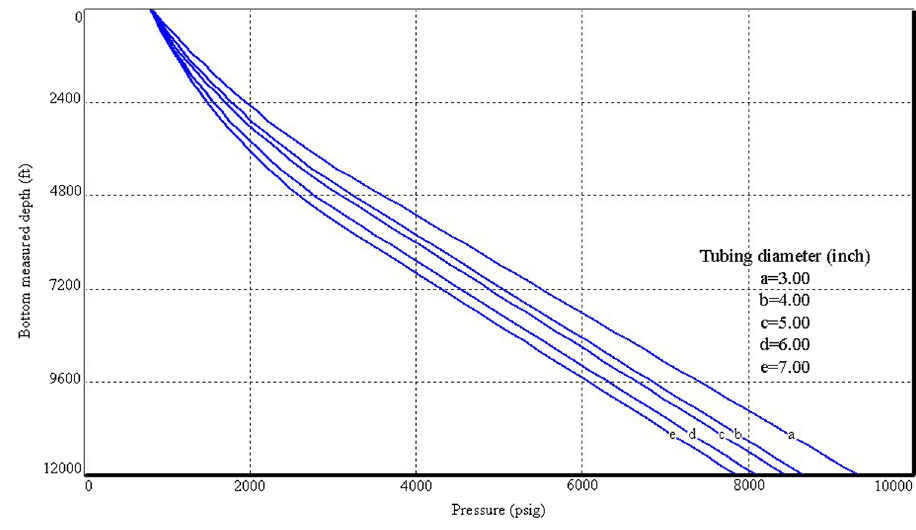
Fig. 18 Temperature profile in the well for different tubing